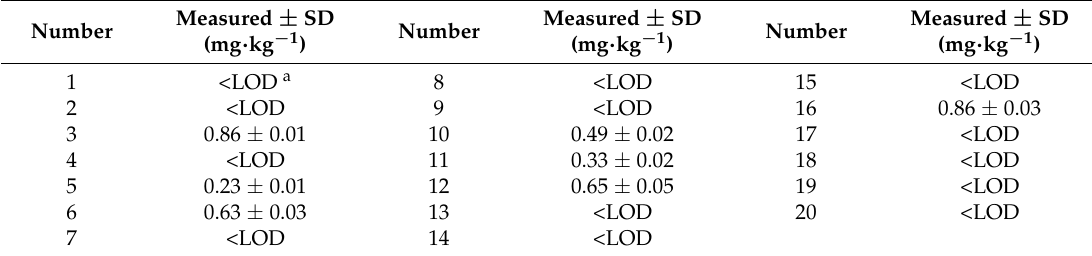
Table 4. Residues of prochloraz in authentic apple samples.